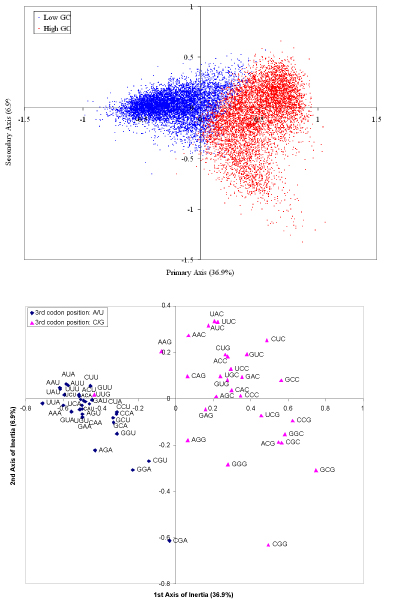
Correspondence Analysis of relative synonymous codon usage (RSCU) for all 14,005 rice genes. Panel A. This panel shows the distribution of genes on the primary and secondary axes (accounting for 36.9% and 6.9% of the total variation, respectively). The two classes of genes (High GC and Low GC) are color coded; the high GC genes are shown in red and the low GC genes are shown in blue. Panel B. This panel shows the underlying distribution of codons on the same two axes as shown in Panel A. Codons ending with G or C are shown in red, and codons ending with A or U are shown in blue.